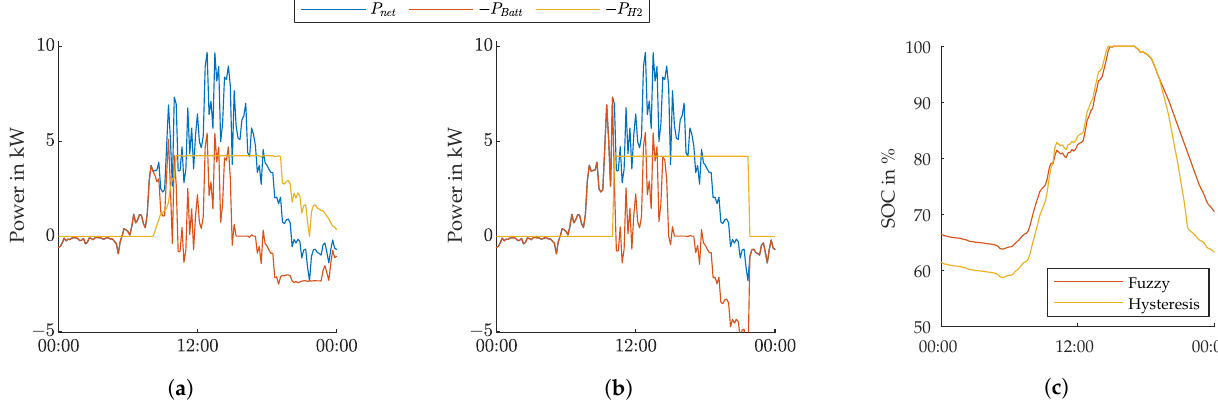
Figure 11. Timeseries summer day. ( a ) Expert tuned fuzzy logic controller. ( b ) Three-point hysteresis controller. ( c ) Battery SOC profiles.